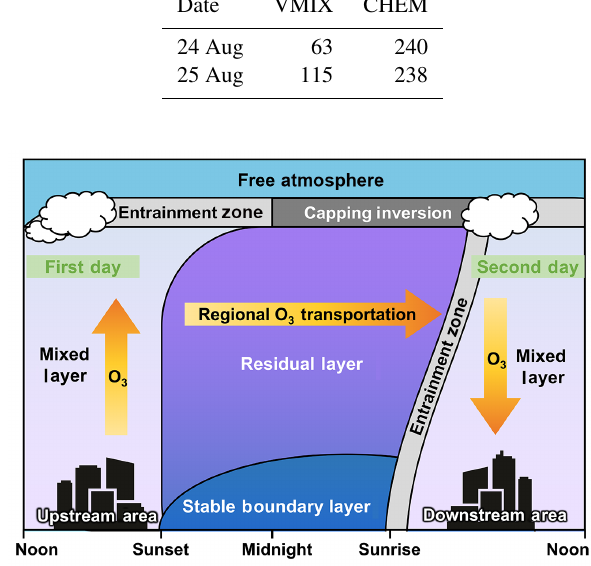
Figure 8. A diagram of the regional O 3 transport mechanism pro- posed in this